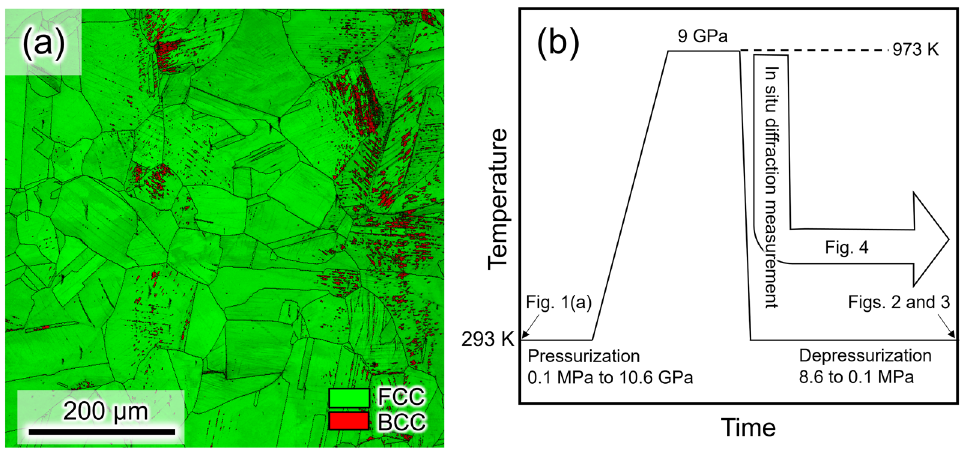
Figure 1. ( a ) Phase map showing the as-solution-treated specimen, and ( b ) schematic for the hydrogenation treatment. The schematic was drawn by power point for Microsoft